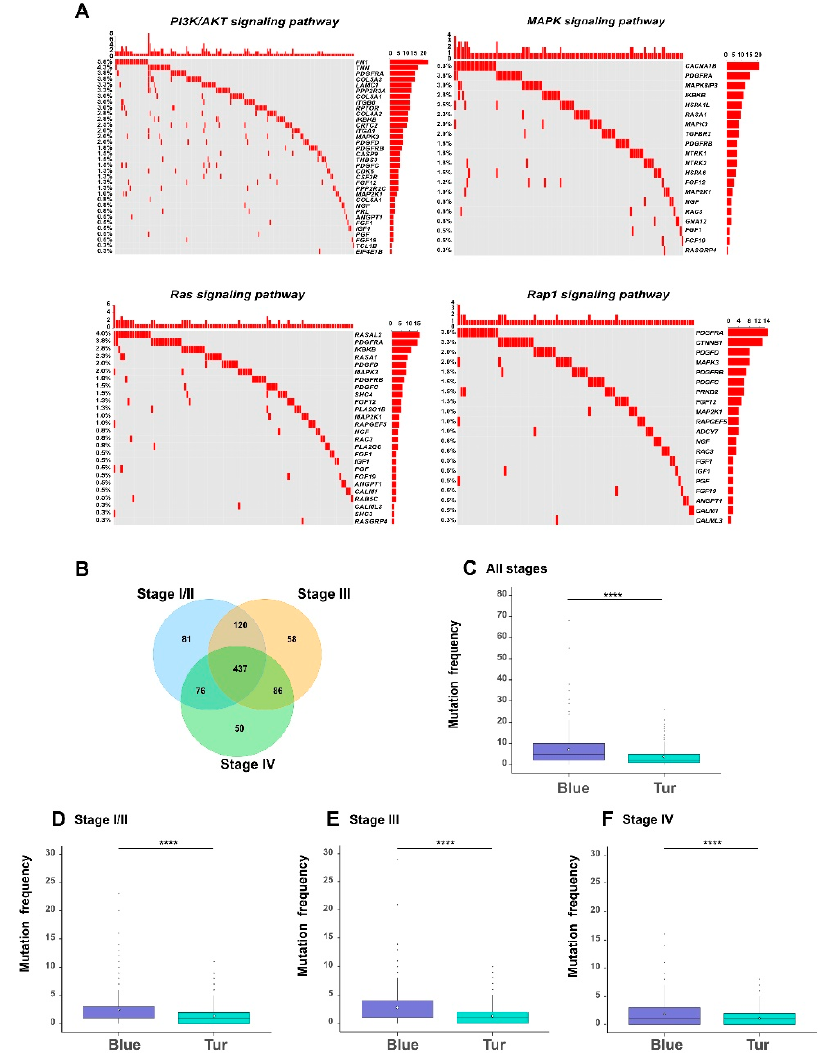
Figure 7. The functional signatures of somatic mutations. ( A ) The oncoprints of four examples of cellular signaling pathways that were significantly enriched with the mutated genes in BLCA samples, including PI3K / AKT pathway, MAPK pathway, Ras pathway and Rap1 pathway. Rows represent the mutated genes, which were ranked according to the frequencies of mutated genes in all samples, and columns represent the involved samples. ( B ) A Venn diagram showing the overlap of mutated genes among di ff erent stages of bladder cancer. The comparisons of the frequencies of somatic mutations between blue and turquoise modules. The white diamonds represent the mean of mutation frequency ( C – F ). * p -value < 0.05; ** p -value < 0.01; *** p -value < 0.001; **** p -value < 0.0001; two-sided Student’s t -test.